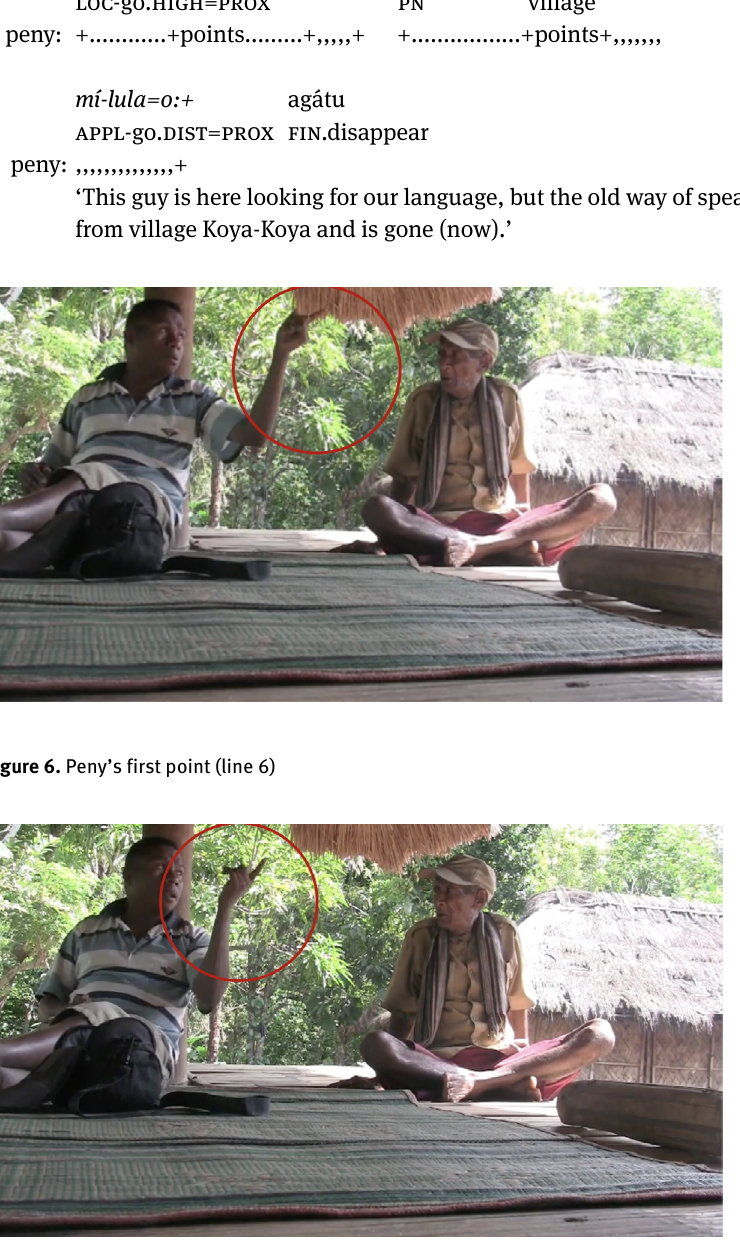
Figure 7. Peny’s second point (line